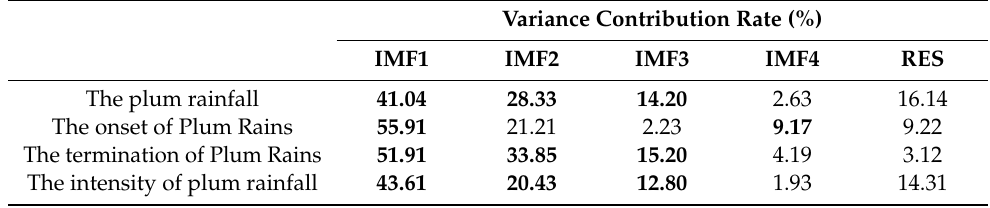
Table 1. The variance contribution rates of EEMD for plum rainfall, the onset and termination of Plum Rains, and the intensity of plum rainfall.